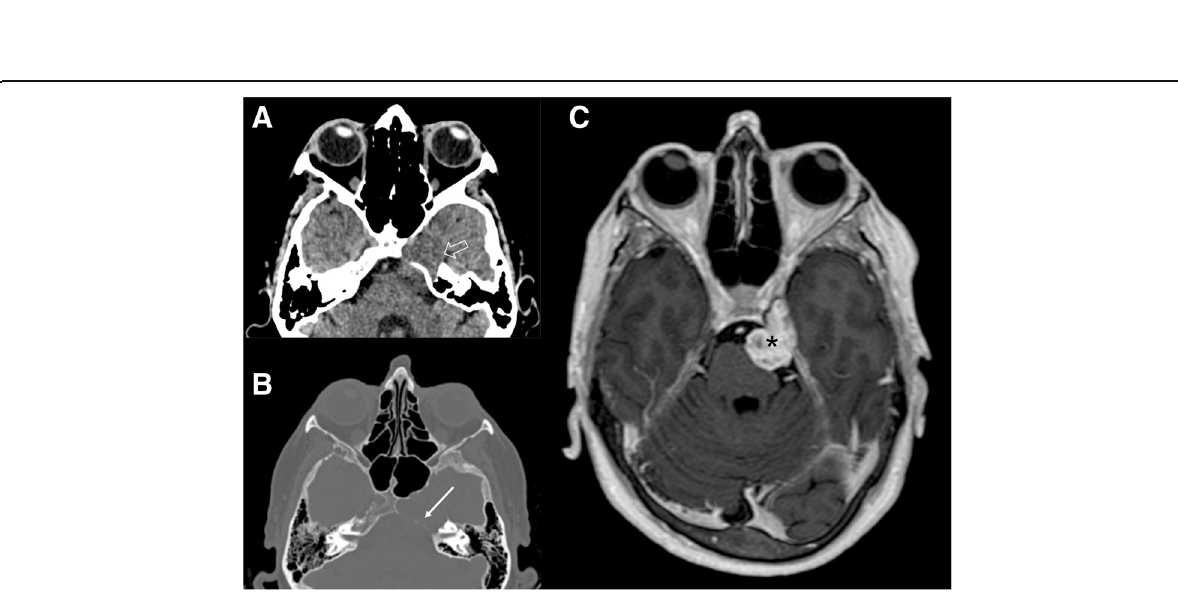
Fig. 13 Large trigeminal schwannoma. CT axial image (soft tissues and bone windows, a , b , respectively) demonstrates a mild iso-attenuated mass (empty arrow) with erosion of the left petrous apex (arrow); MRI T1-weighted post-gadolinium axial image ( c ) shows an avid enhancing dumbbell-shaped mass (asterisk), that extends in the Meckel ’ s cave, along the cisternal course of the left trigeminal